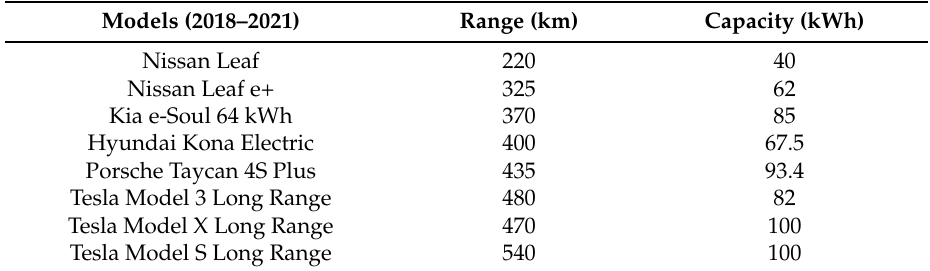
Table 1. EV battery capacity commercially available.